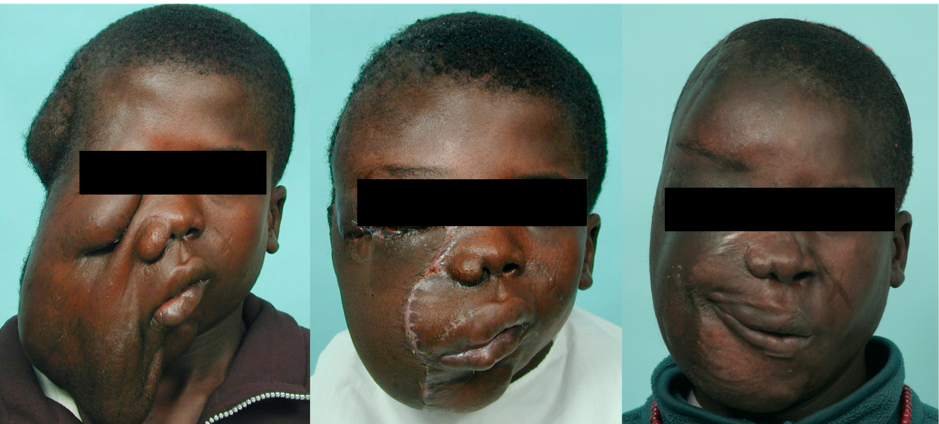
Figure 4. Clinical images of a 15-year-old adolescent boy from Africa who presented with diffuse plexiform craniofacial neurofibromatosis with no ipsilateral facial nerve function and no vision. After preoperative embolization (right superficial temporal, internal maxillary, and facial arteries) and intraoperative ligation of the right external carotid artery, a radical excision of the tumor with orbital repositioning was performed. Microsurgical free flaps (anterior lateral thigh flap and myocutaneous gracilis free flap) were transferred to reconstruct the facial defect. Additional procedures included orbitotomy, skull base tumor removal, and right fronto-orbital craniotomy, with orbital and craniofacial reconstruction and ocular prosthesis placement.